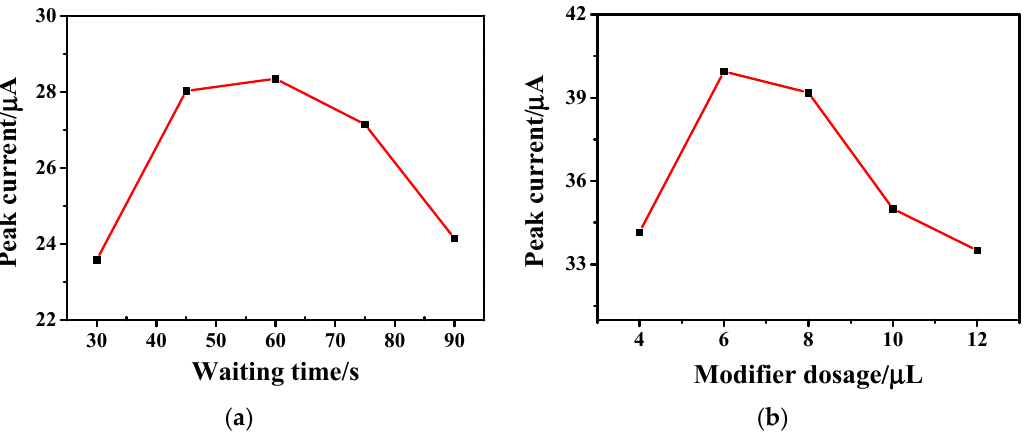
Figure 6. Relationship between ( a ) waiting time and ( b ) modifier dosage and oxidation peak current obtained by 1 × 10 − 4 M AC on Fe 3 O 4 -rGO/GCE electrodes at a scan rate of 100 mV·s − 1 in PBS buffer solution (pH = 5.0).